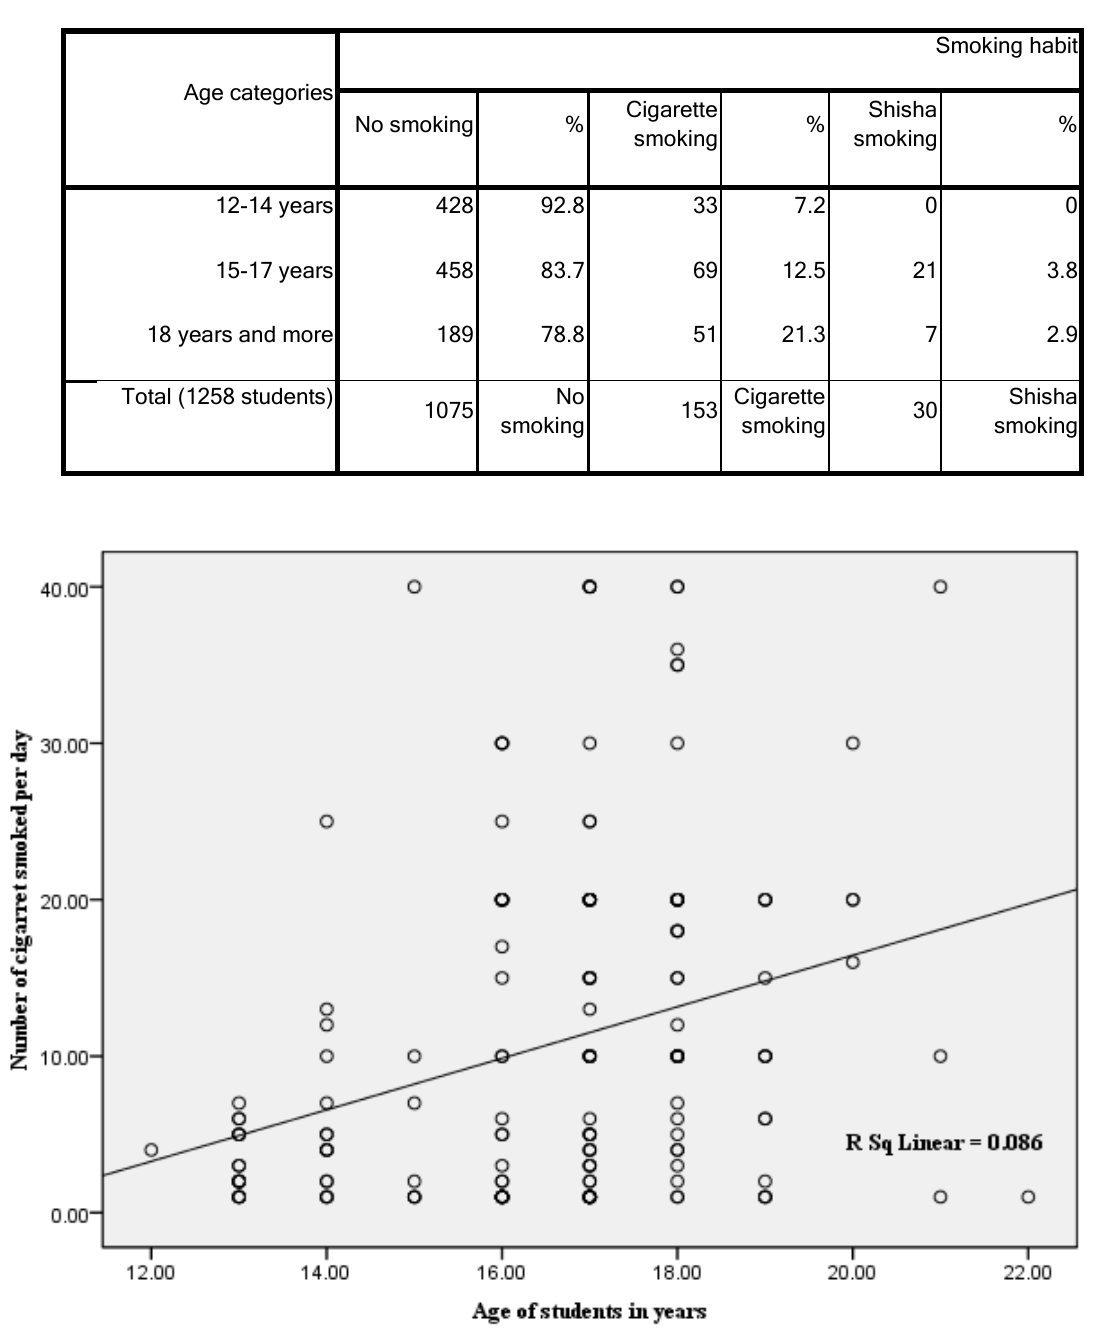
Table 4 shows distribution of smoking habit among students according to their age